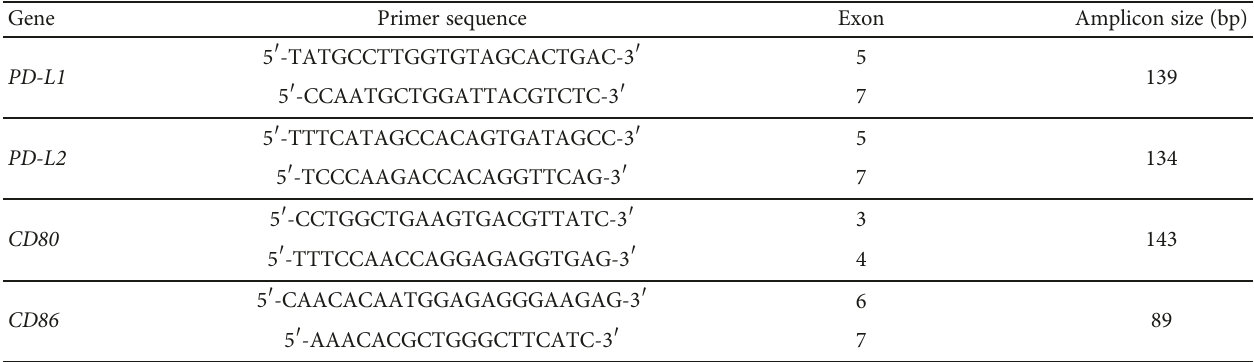
Table 1: Sequence, exon position, and amplicon size of the primers used in quanti fi cation of human PD-1 and CTLA-4 gene expression in thyroid